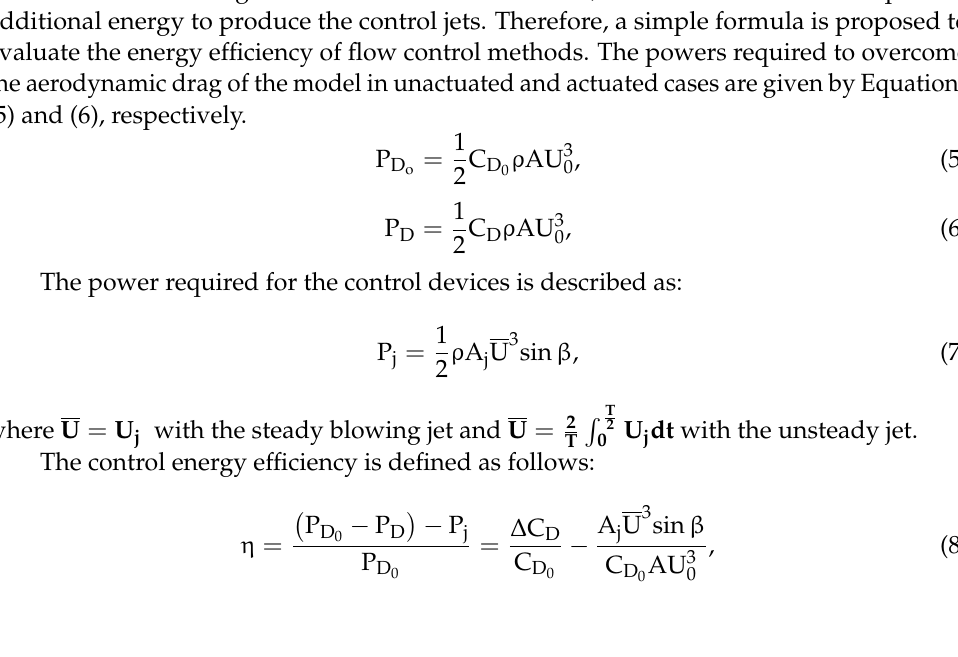
Figure 27. The normalized streamwise contour at the iso-surface Q = 300,000 s − 2 with the unsteady jet at different control frequencies. ( a ) fc = 68 Hz; ( b ) fc = 272 Hz.